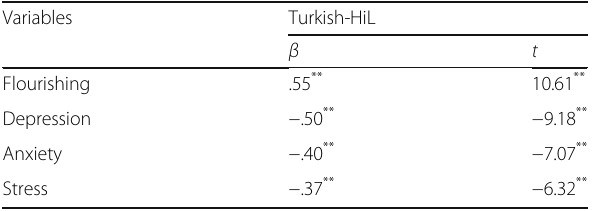
Table 4 Regression results of convergent